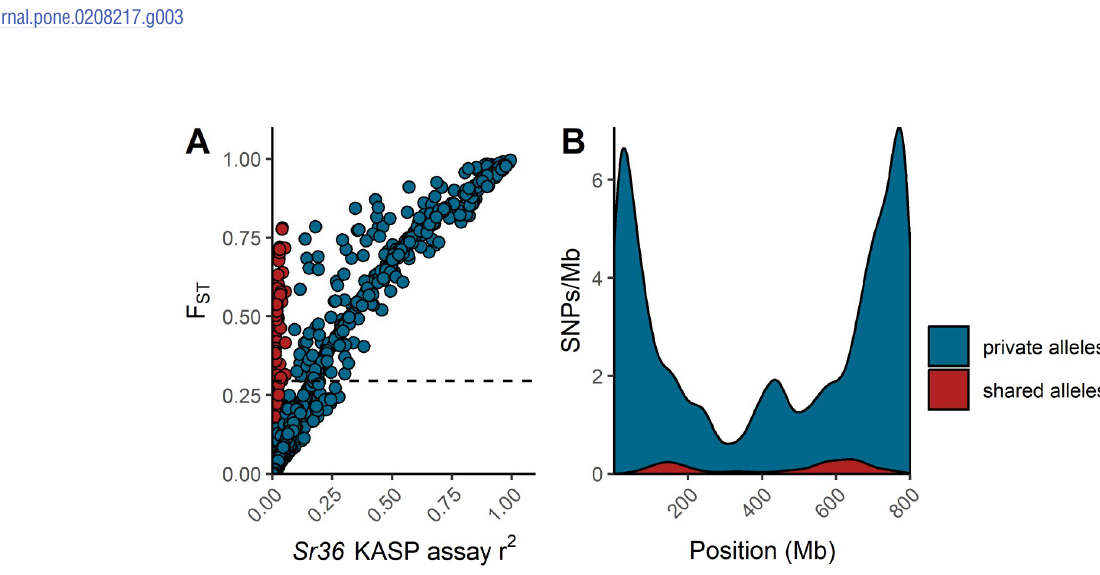
Fig 4. Triticum timopheevi private and shared alleles on chromosome 2B. (A) F Sr36 assay for all SNPs on chromosome 2B. Two clusters of SNPs were manually differentiated—those with putative Triticum timopheevi private alleles for which F ST and r 2 values show a general linear relationship (blue), and those with putative Triticum timopheevi / Triticum aestivum shared alleles for which F Horizontal dashed line represents the 99 th percentile of genome-wide F ST values, excluding SNPs on chromosomes 2A, 2B, and 2D. (B) Density plots of both classes of SNPs across chromosome 2B.